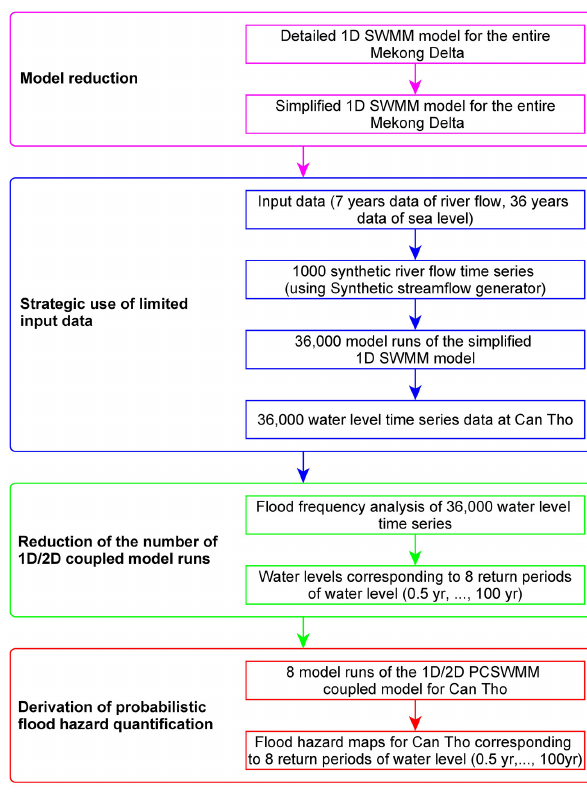
FIGURE 3 | The methodological framework adopted to derive probabilistic flood hazard estimates for the study area. This process was applied for the present and for 2050 (RCP 4.5 and RCP 8.5 together with 3 different local land subsidence scenarios).